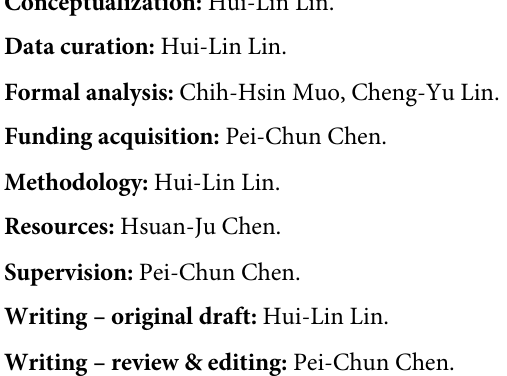
S1 Table. The disease and ICD-9-CM